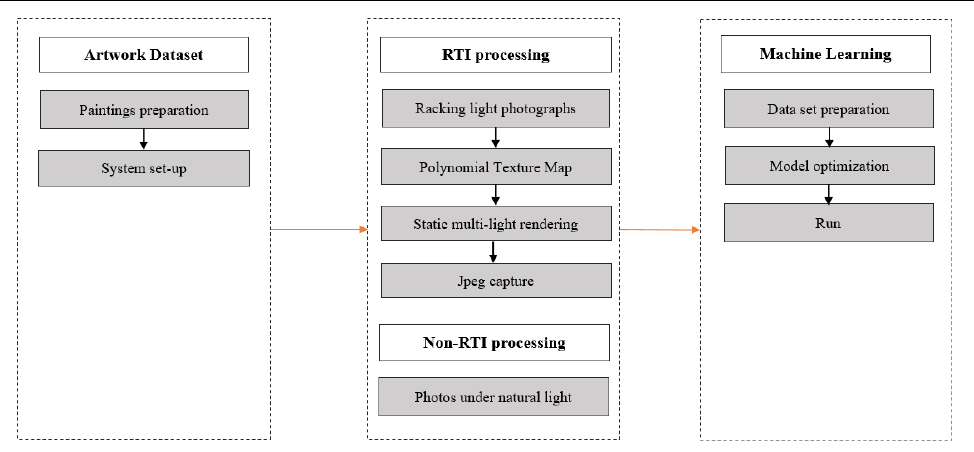
Figure 1. Pipeline of this research for oil painting classification using depth information.